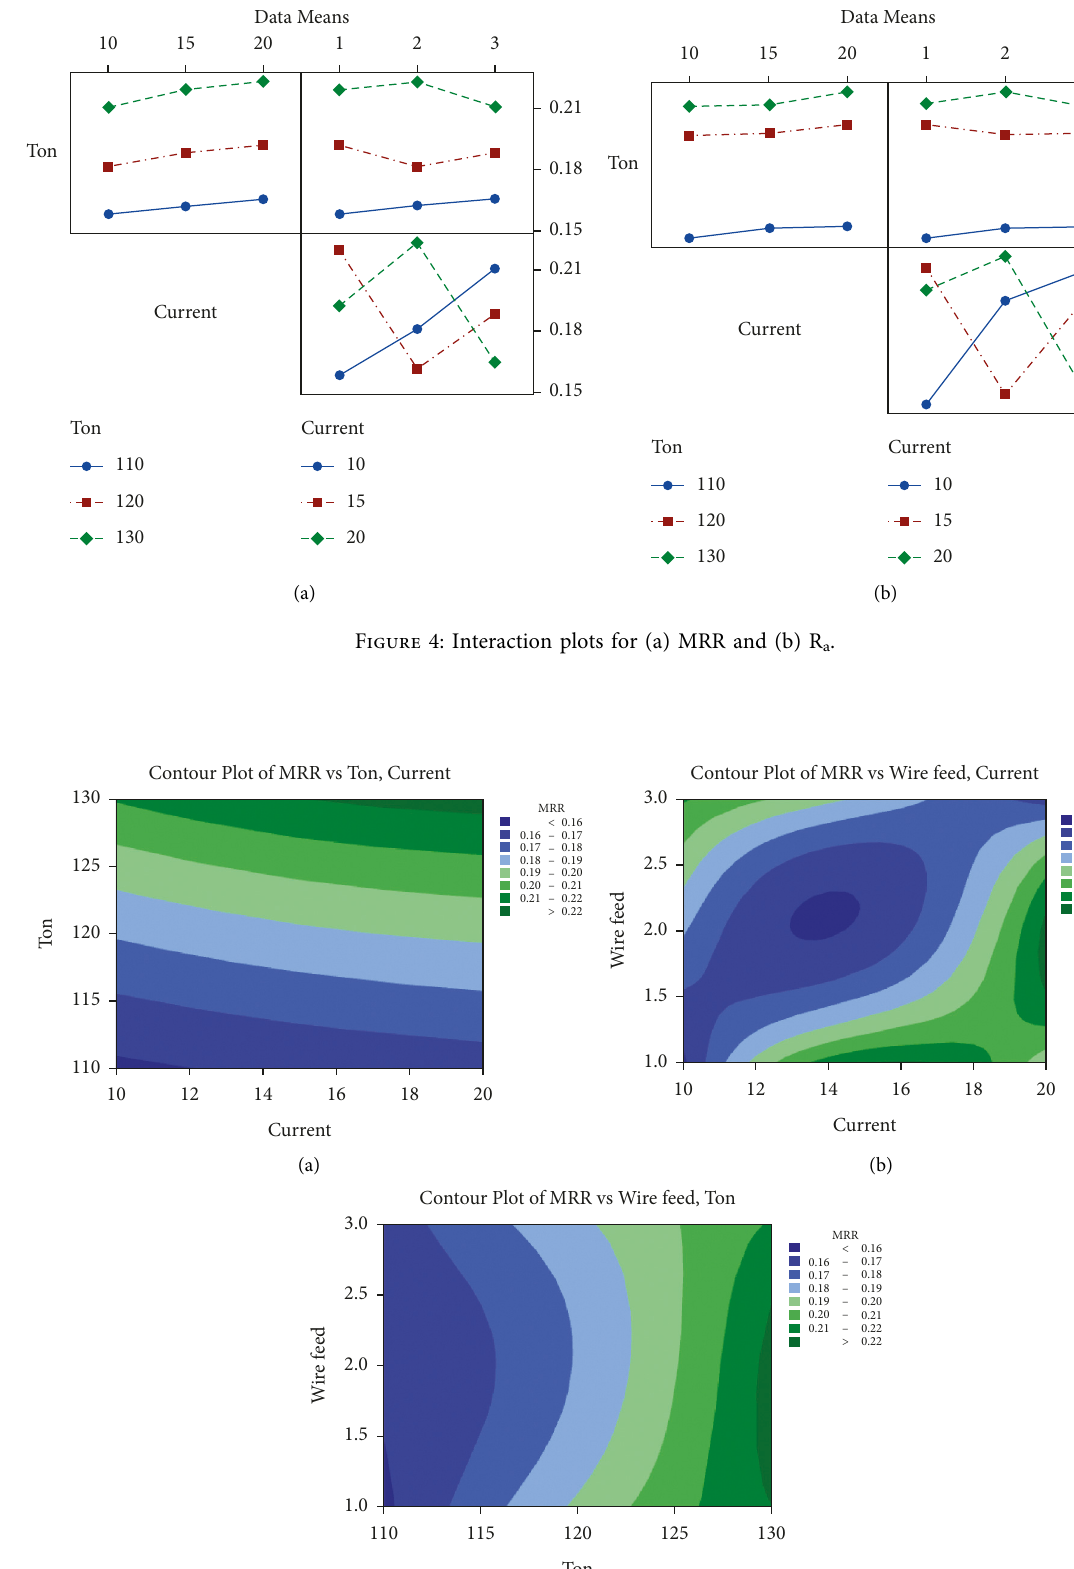
Figure 5: Contour plot for MRR: (a) T ON and current, (b) wire feed and current, and (c) T ON and wire